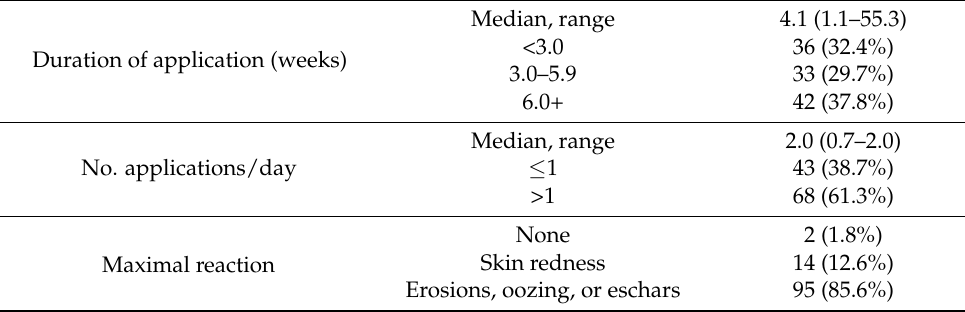
Table 2. Imiquimod therapy in the study population ( n = 111).